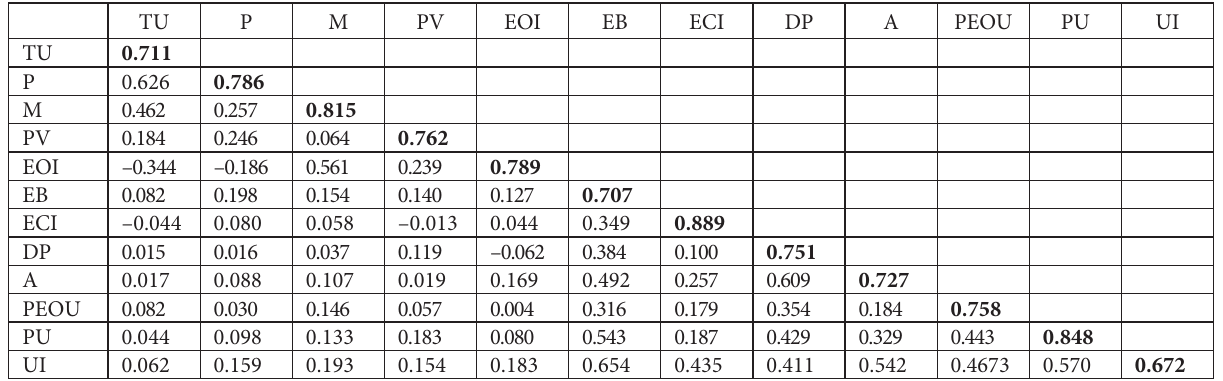
Table 3. Pearson correlation coefficients